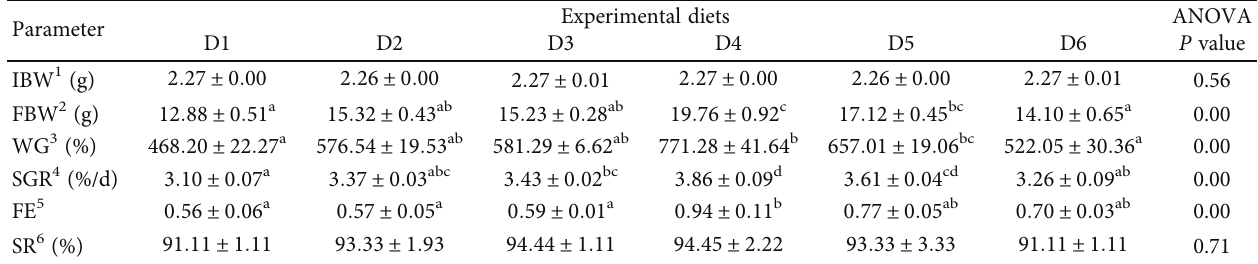
Table 4: Growth performance, feed utilization, and survival rate of juvenile Acanthopagrus schlegelii fed experimental diets under low- salinity environment for 8 weeks.